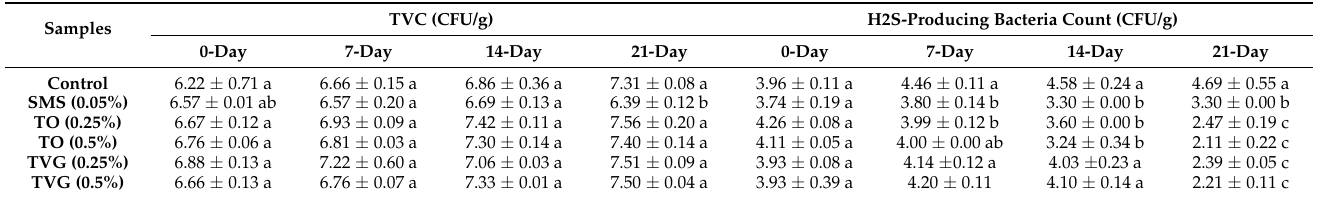
Table 5. TVC and H2S-producing bacteria count of vacuum-packed beef mince treated with TO and TVG during refrigerated